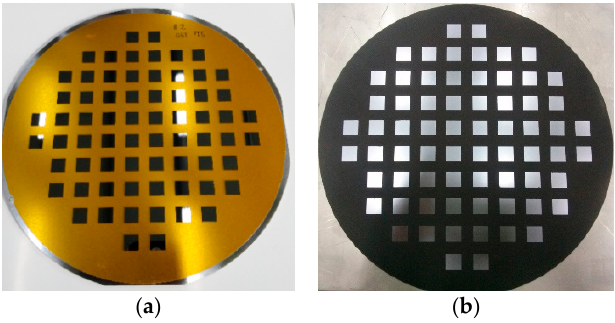
Figure 8. Specimen comparison: ( a ) before molding; ( b ) after debonding. Table 1. Material properties of epoxy molding compound (EMC).